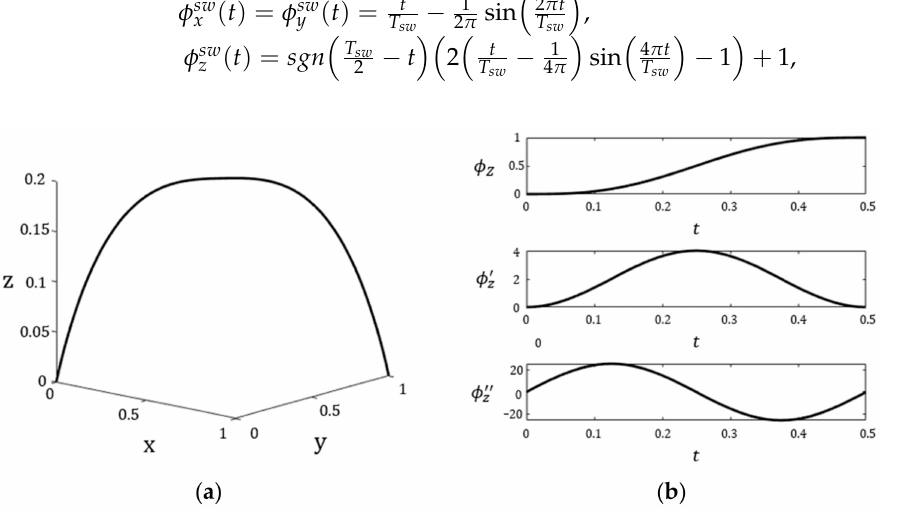
Figure 5. Improved cycloidal trajectory ( a ) and cycloidal curve in z-axis ( b ). The modified cycloidal curve eliminates sudden acceleration change in the z-axis direction, as shown in ( b